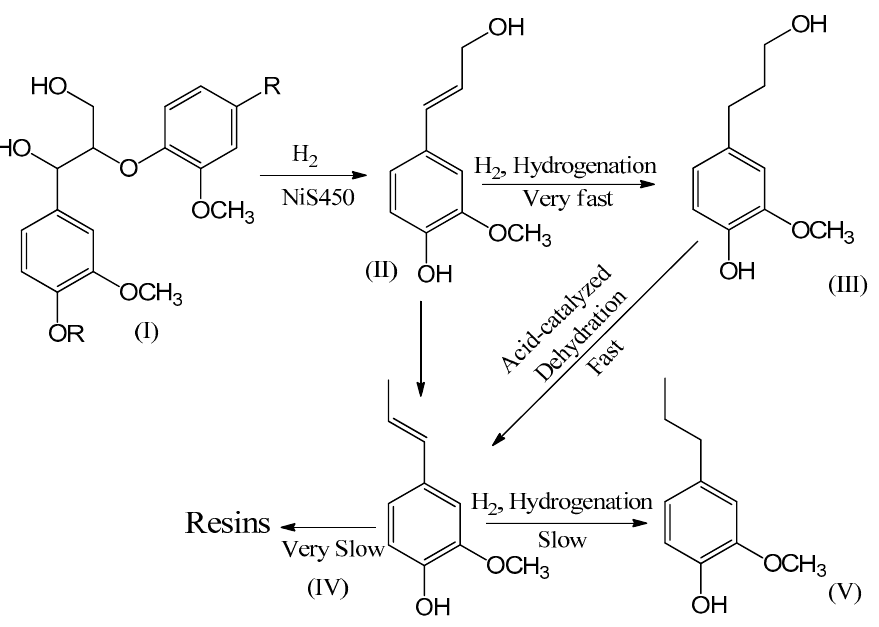
Figure 9. Scheme of depolymerization and conversion of intermediates to 4-propyl guaiacol and 4-propanol guaiacol.